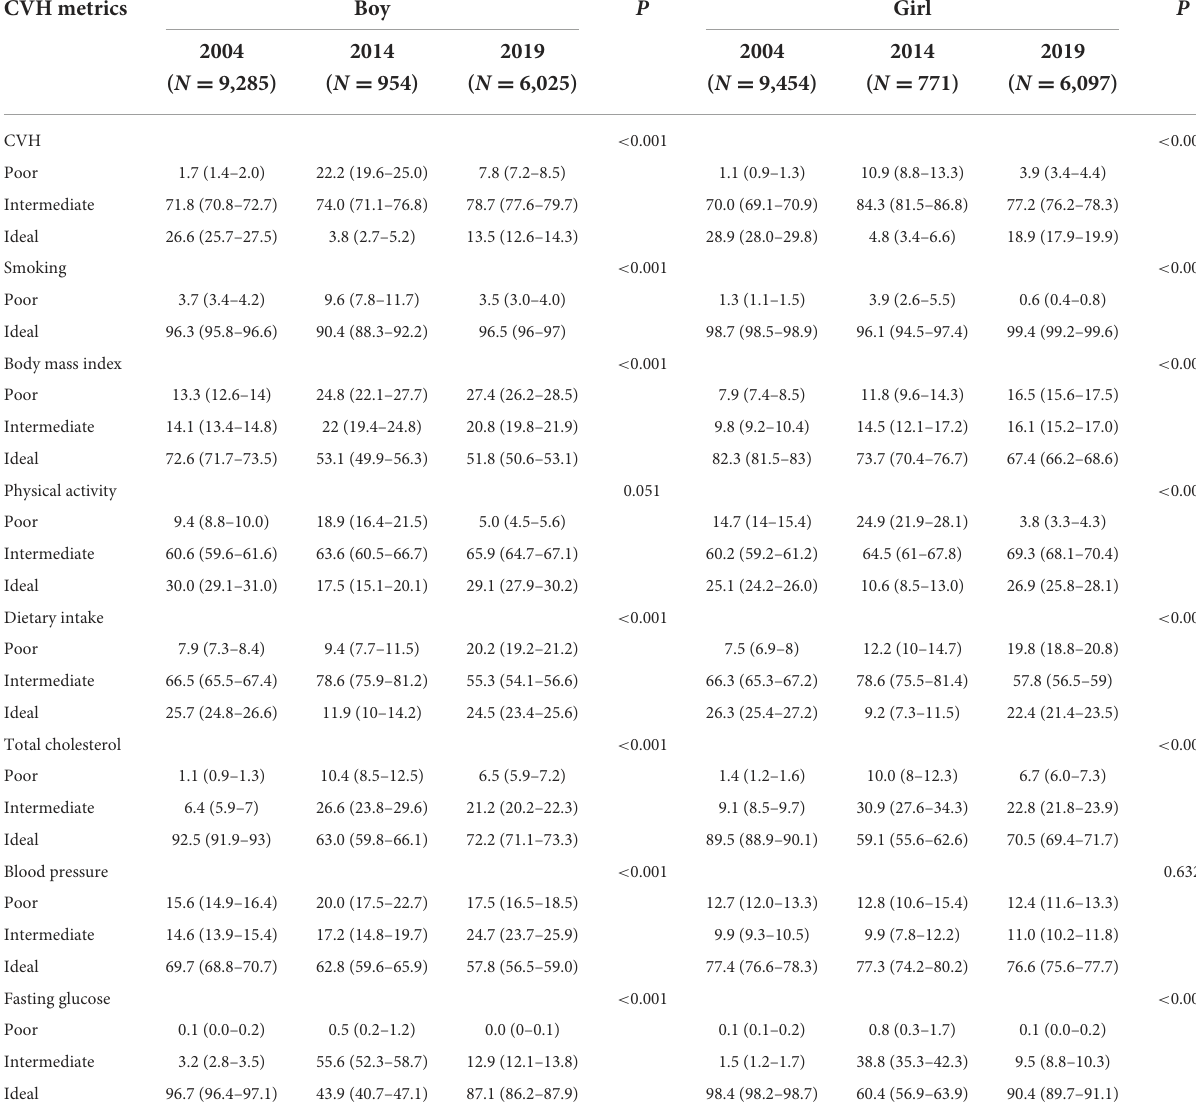
TABLE 5 Proportions (95% CI ) of poor, intermediate, and ideal cardiovascular metrics by sex: